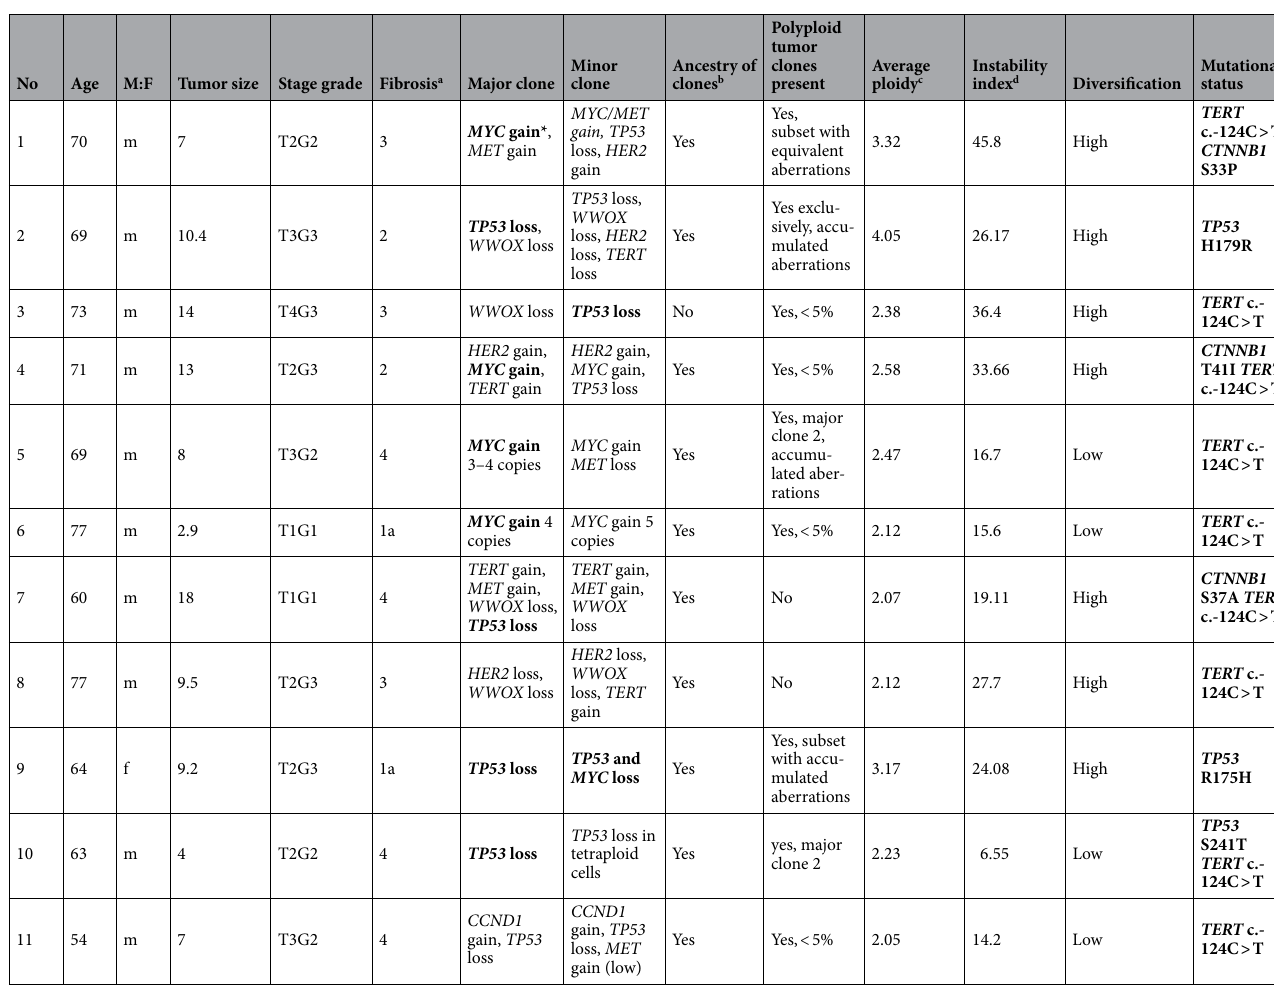
Table 1. Summary of ploidy, numerical aberrations and instability index in NASH-induced hepatocellular carcinoma cases. a Fibrosis stage specific for nonalcoholic fatty liver disease/nonalcoholic steatohepatitis scoring. b Ancestry/relation of clones assessed by phylogenetic tree modelling. c Ploidy calculated from centromere probes of lesional (cancer) cells. d Instability index calculated as number of signal patterns/100